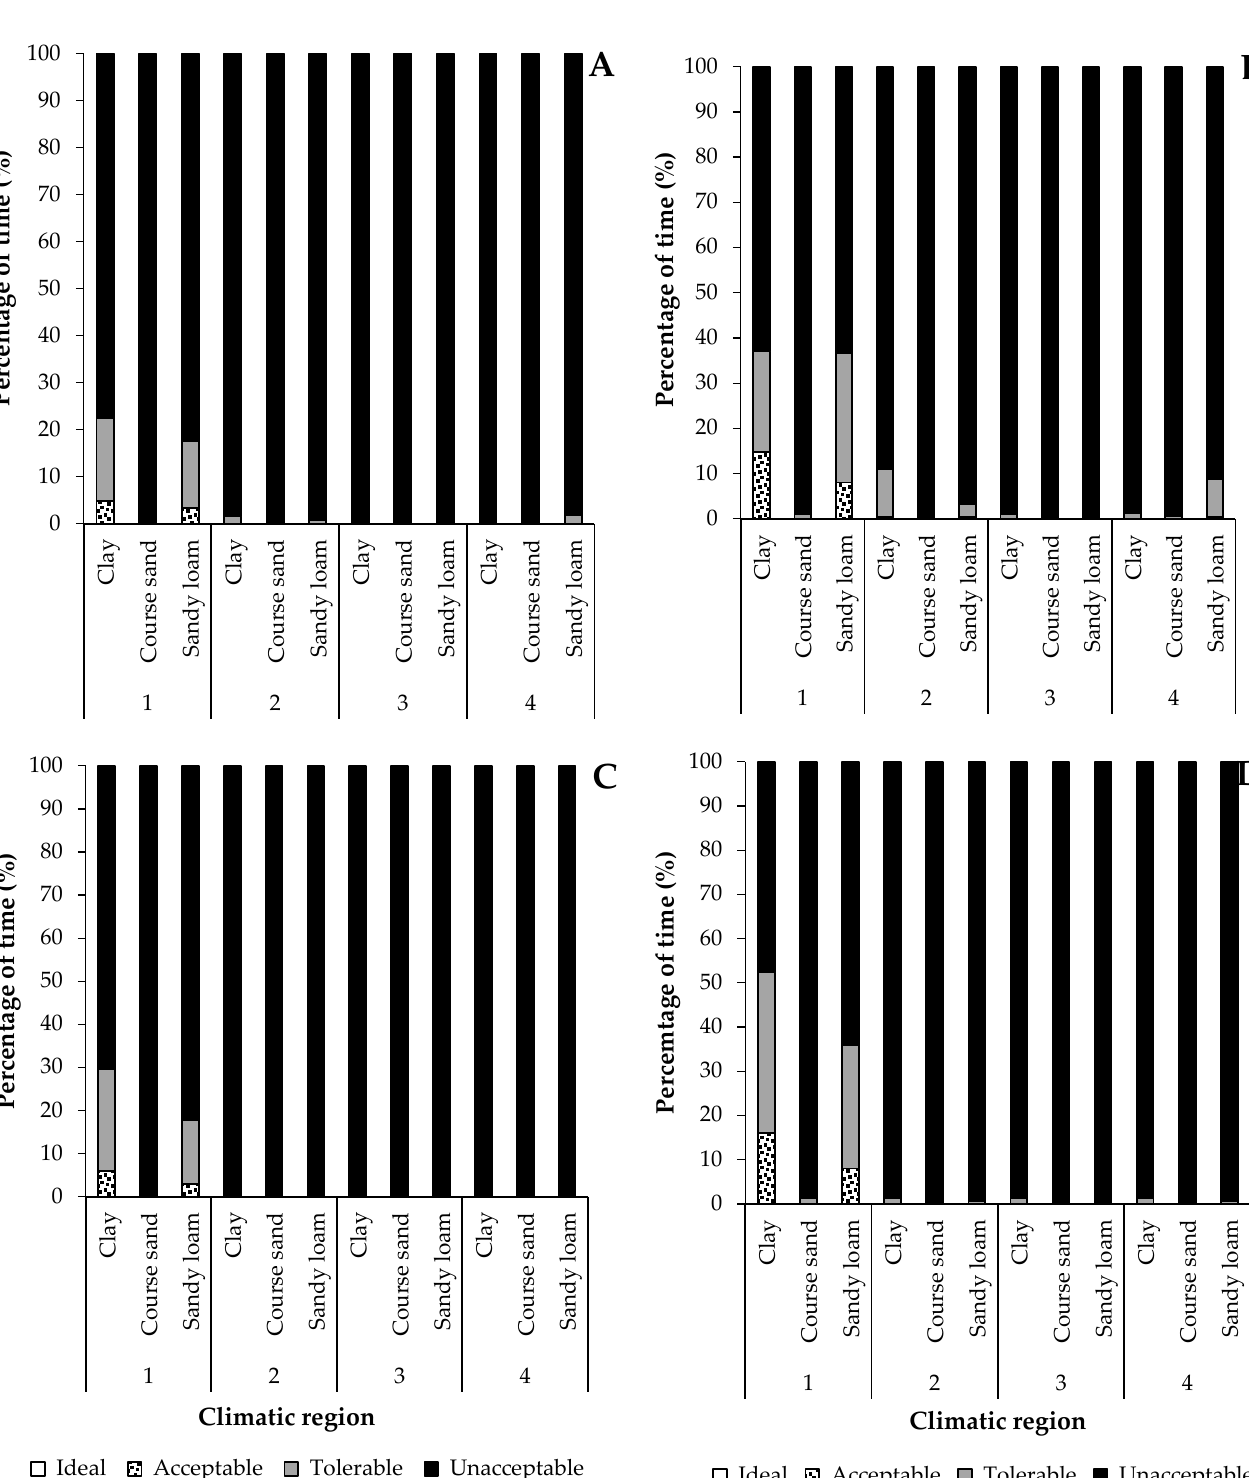
Figure 3. Assessment of AF effluent for fitness-for-use; impacts of irrigation system and soil type on maize crop yield and quality in different climatic regions ( n = 3). ( A ) (Maize, N uptake, overhead irrigation), ( B ) (Maize, P uptake, overhead irrigation), ( C ) (Maize, N uptake, surface irrigation), ( D ) (Maize, N uptake, surface irrigation). 1; Climatic region 1, 2; Climatic region 2, 3; Climatic region 3 and 4; Climatic region 4.